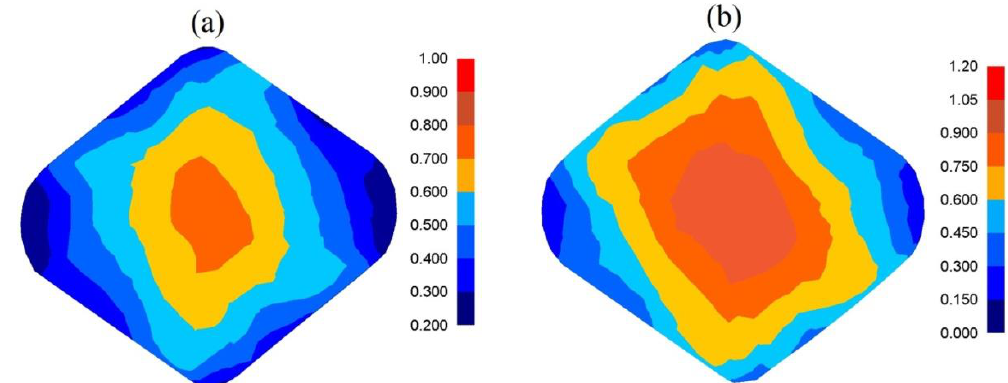
Figure 10. Distribution of effective strain after the cogging process in anvils with skew working surfaces after the second pass (reduction ratio 0.70): ( a ) feed rate of 0.75; ( b ) feed rate of 1.20.